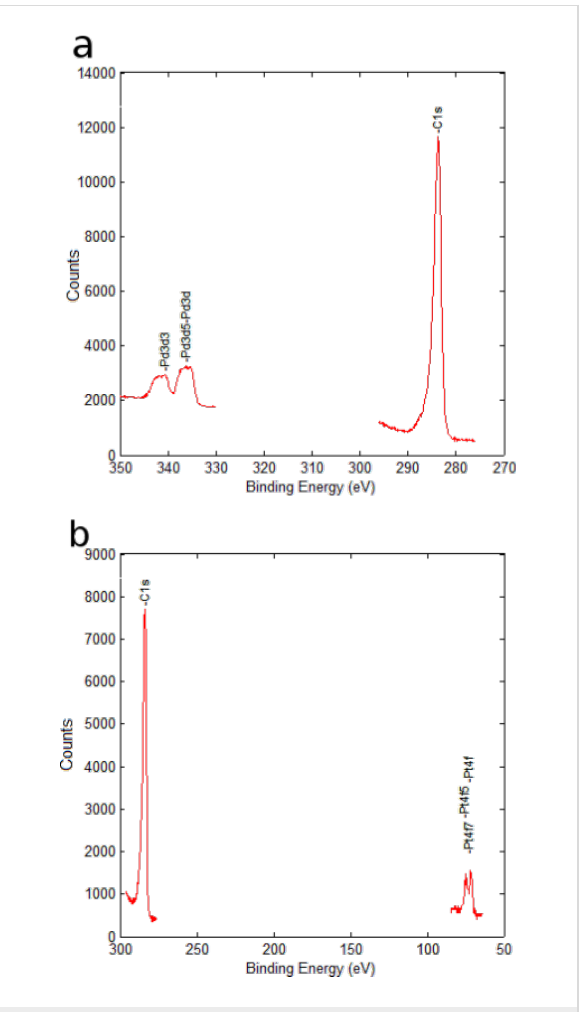
Figure 2: High-resolution XPS spectra in the C 1s and Pd 3d regions of a Pd–MWCNT sensor (top) and the C 1s and Pt 4f regions of a Pt–MWCNT sensor (bottom).